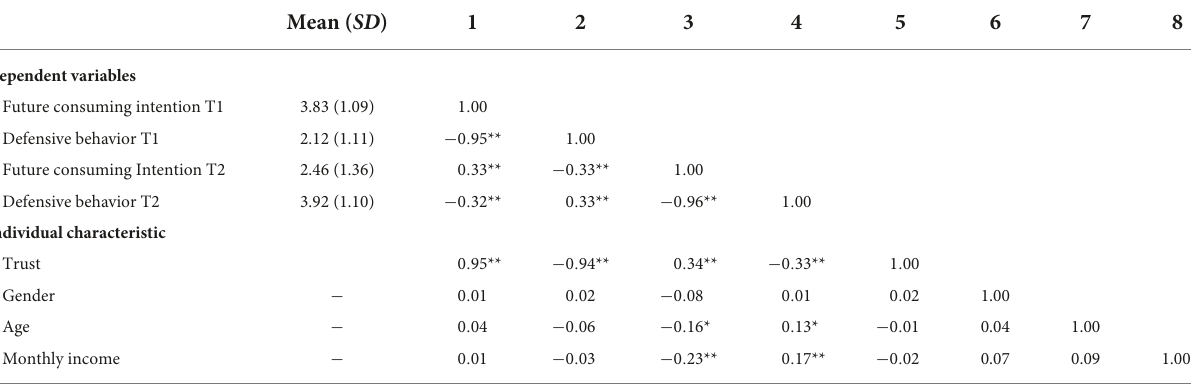
TABLE 1 Descriptive statistics and correlations between studied